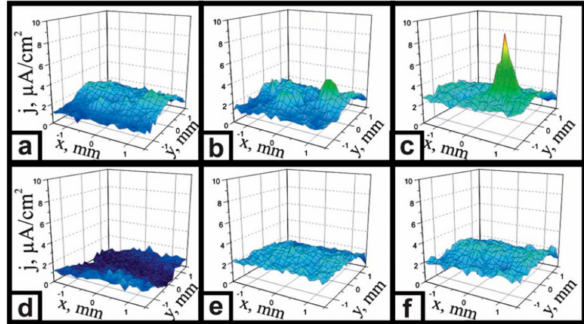
Figure 13. The current density distribution above scratched aluminium substrates covered with ( a – c ) control epoxy coating and ( d – f ) epoxy coating modified with 5 wt% of MeBT doped microgel particles: a , d —0 h of immersion, b , e —6 h of immersion, c , f —12 h of immersion in 0.1MNaCl solution. Adapted from [66], with permission from © 2012 Royal Society of